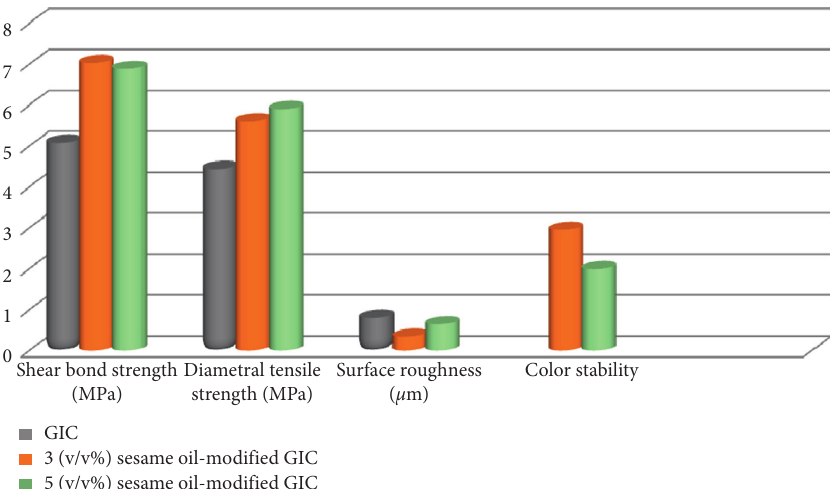
Figure 3: A graphical presentation of shear bond strength, diametral tensile strength, surface roughness, and color stability results of the studied groups.